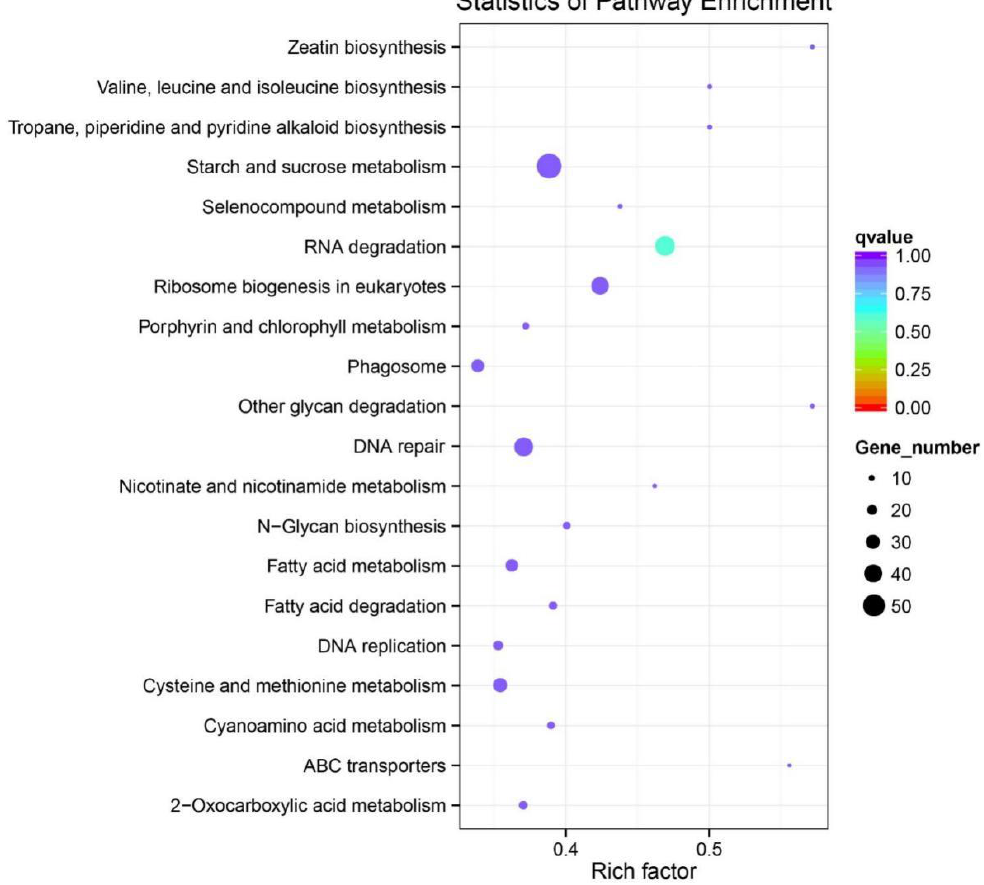
Figure 8. KEGG analysis of the top 20 enriched pathways. The coloring of the q-values indicates the reliability of the rich factor. The dot indicates the target genes involved in the pathway, and the size represents the number of genes where a larger dot represents a greater number of genes. The ordinate lists names of enrichment pathways. The abscissa indicates the rich factor.